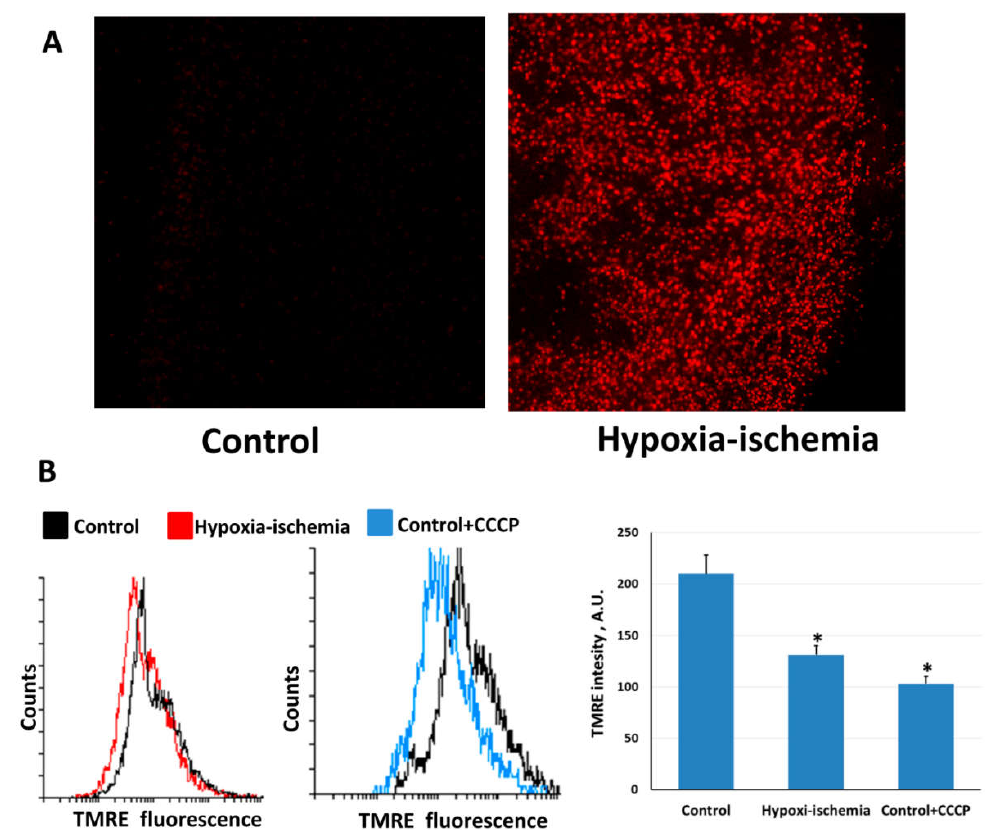
Figure 1. Hypoxia–ischemia increases mitochondrial ROS production in brain cells as measured by MitoSOX staining in brain slices obtained after 10 min of reoxygenation ( A ). Mitochondrial dysfunction is documented by a decreased mitochondrial membrane potential, as monitored by TMRE fluorescence ( B ). * p < 0.05 compared to control, one-way ANOVA, followed by Tukey’s post hoc analysis.